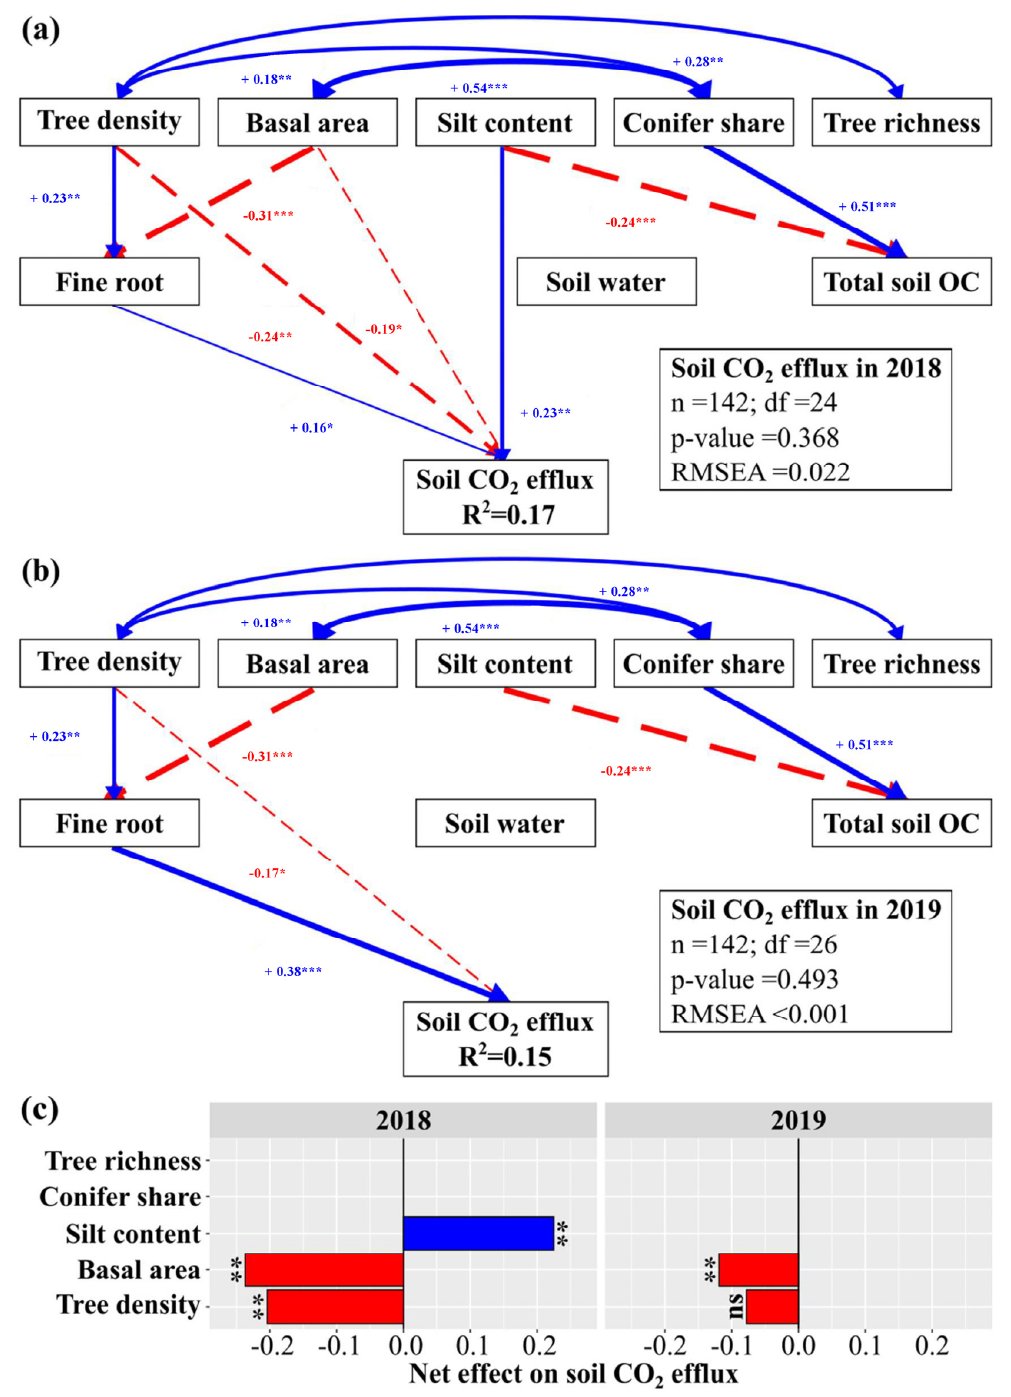
Figure 5. Structural equation models of soil CO 2 efflux measured ( a ) in 2018 and ( b ) in 2019 and ( c ) net effects. Mediation variables include fine root biomass, volumetric water content and total soil organic carbon stocks (mineral soil OC and organic layer stocks). Number of observations (n), degrees of freedom (df), fitness statistics ( p -value, RMSEA) and standardized path coefficients and their significance level are given. Single-headed arrows represent direct paths and double-headed arrows represent covariances. Solid blue arrows represent positive associations, and dashed red arrows represent negative associations. Thin arrows represent associations with p < 0.050 (*), medium-width arrows represent p < 0.010 (**) and thick arrows represent p < 0.001 (***). Coefficients of determination are given for soil CO 2 efflux.